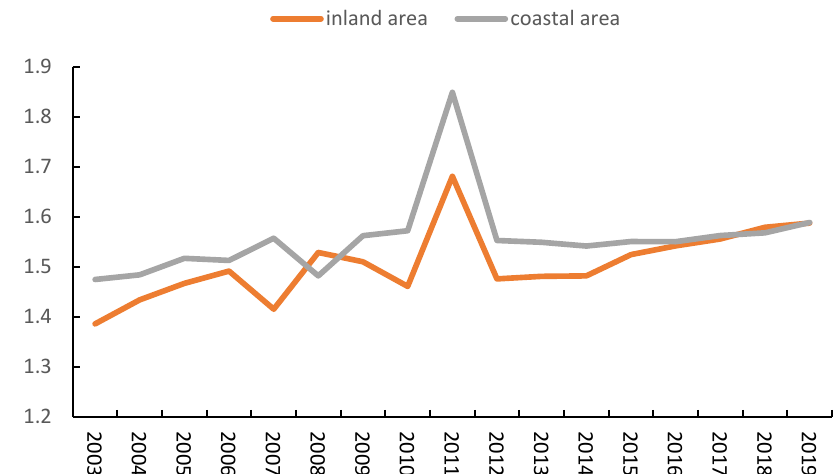
Figure 3. Upgrading level of fishery industrial structure from 2003 to 2019.